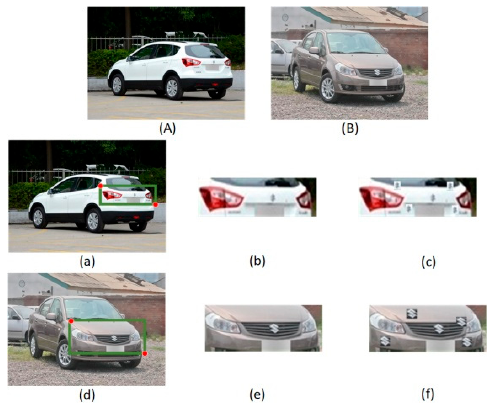
Figure 4. Process of constrained region segmentation and the copy-pasting strategy; ( A ) and ( B ) are original vehicle sample; ( a ) and ( d ) show the detected constrained region; ( b ) and ( e ) are the cropped constrained region; ( c ) and ( f ) show the images processed with “copy-pasting” strategy.